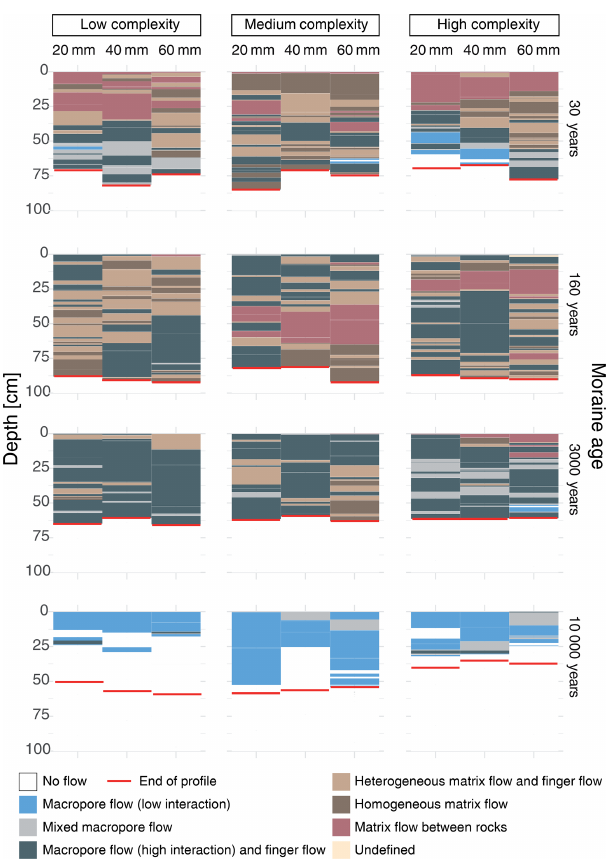
Figure 9. Profiles of flow types per age class, vegetation complex- ity, and irrigation amount.